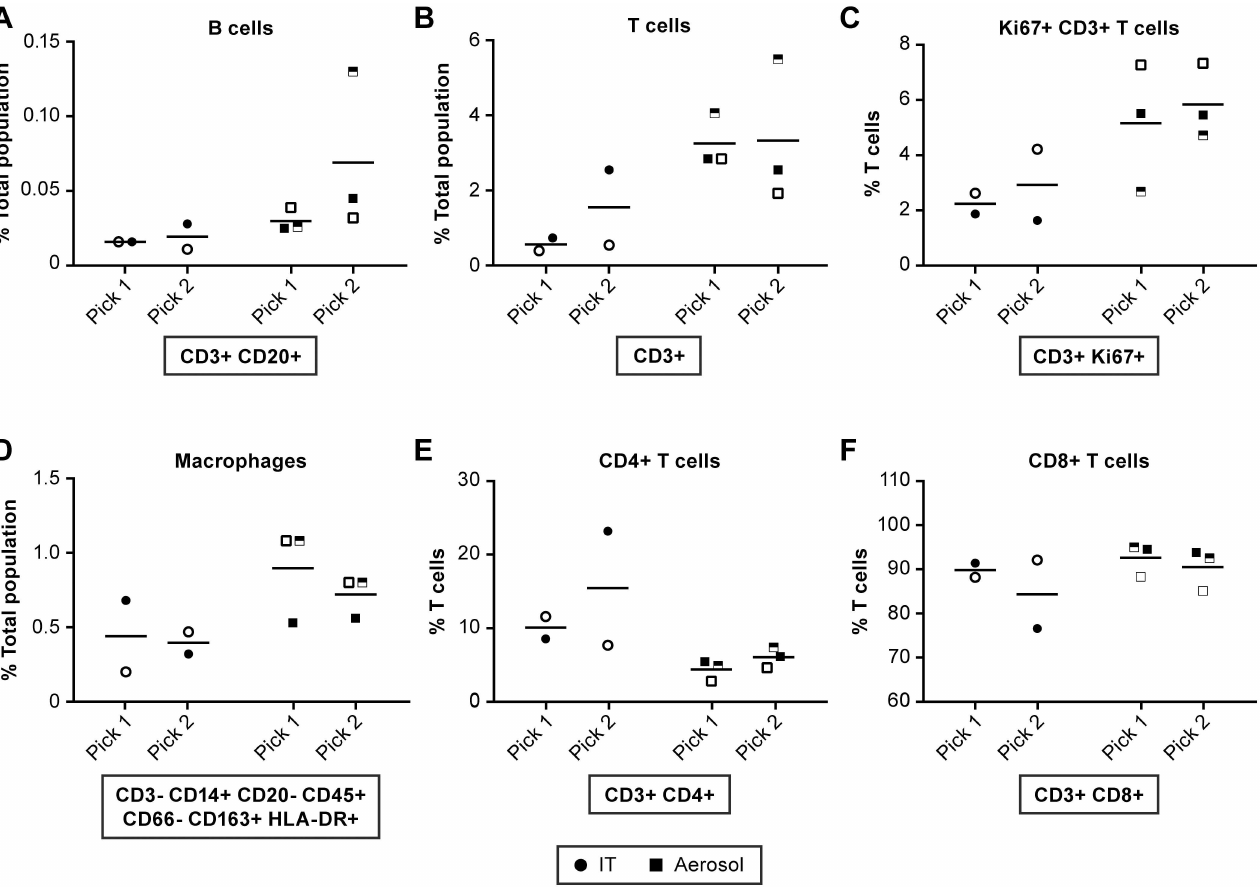
Fig 10. Evaluation of immune cell populations in the brain collected at necropsy. Comparisonsof immune cell populationsin two samples collectedfrom the cerebralcortex at necropsyfrom animalsinfected by IT ( ● ) or aerosol ( ■ ) inoculation.Markers are consistent for individual animals. IT inoculated:8204( ● ), 8213(half-filled (cid:14) ) and 8181 ( (cid:14) ); Aerosol inoculated:8210 ( □ ), 8095 (half-filled □ ) and 8206 ( ■ ). Represented are data for (A) B cells, (B) T cells, (C) Ki67+ T cells, (D) Macrophages, (E) CD4+ T cells and (F) CD8+ T cells. These data suggestthat T cells infiltrated into the brain of aerosol-infected animalsand that a higherproportionof these cells are activated. There were also an increasednumber of macrophages in the brain of two of the animalsin the aerosol group. Statistical analyseswere not performed due to limited group size.